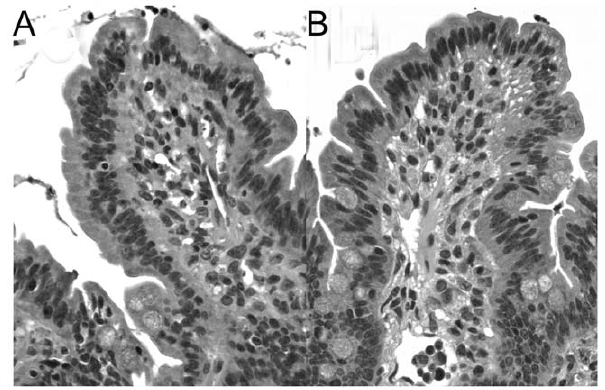
Figure 3. Histological appearance of CRF-treated porcine ileal mucosa on Ussing chambers. Ileal histology (20 6 magnification) of hematoxylin and eosin-stained porcine ileal sections after 180 minutes on Ussing chamber following treatment with vehicle control (A) or 0.5 m M CRF (B). Images are representative of ileal sections from n=6 pigs/treatment.